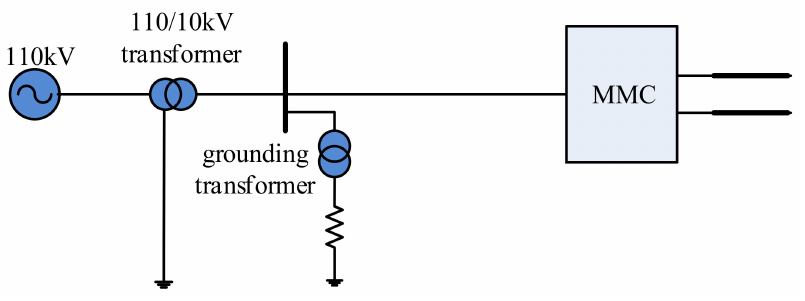
Figure 11. Diagram of the DC distribution system without connection